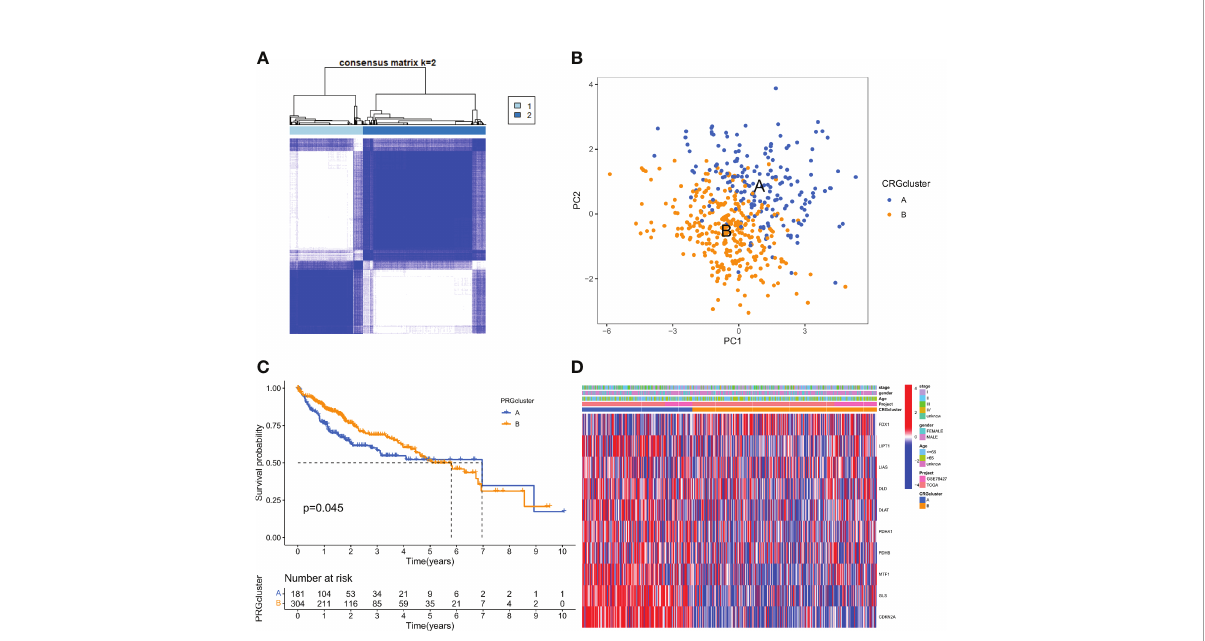
FIGURE 2 CRG subtypes and clinicopathological and biological characteristics of two distinct subtypes of samples divided by consistent clustering. (A) Consensus matrix heatmap de fi ning two clusters (k = 2) and their correlation area. (B) PCA analysis showing a remarkable difference in transcriptomes between the two subtypes. (C) Univariate analysis showing 10 CRGs related to the OS time. (D) Differences in clinicopathologic features and expression levels of CRGs between the two distinct